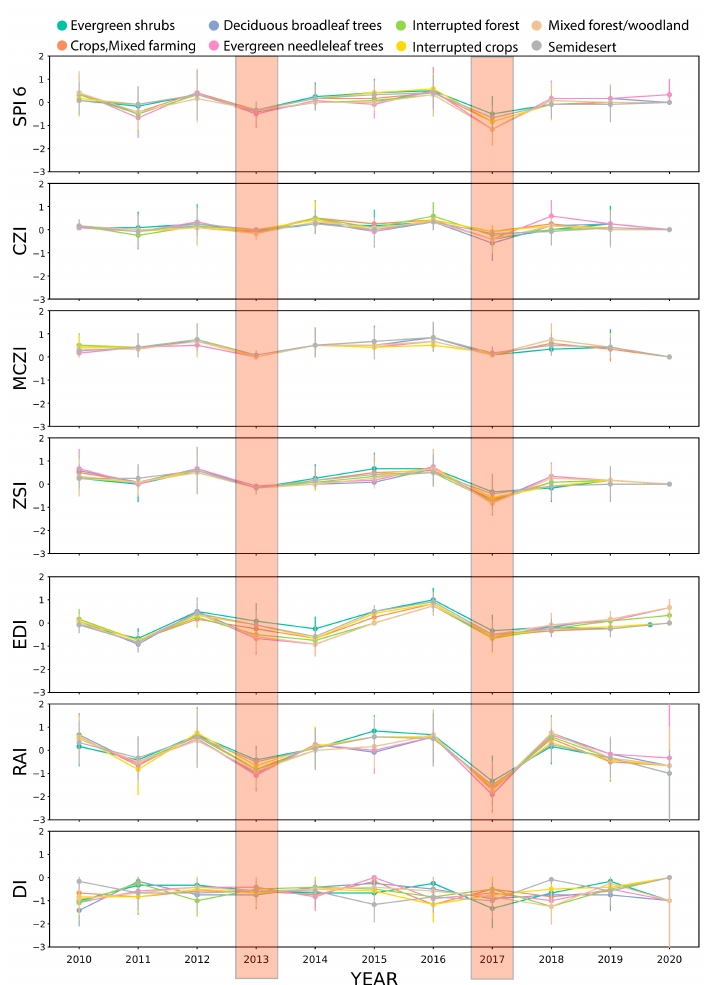
Figure 4. Seven drought indices calculated using ERA5 data for each vegetation type in South Korea (2010–2020). Here, 2013 and 2017, highlighted in red boxes, indicate severe drought years in South